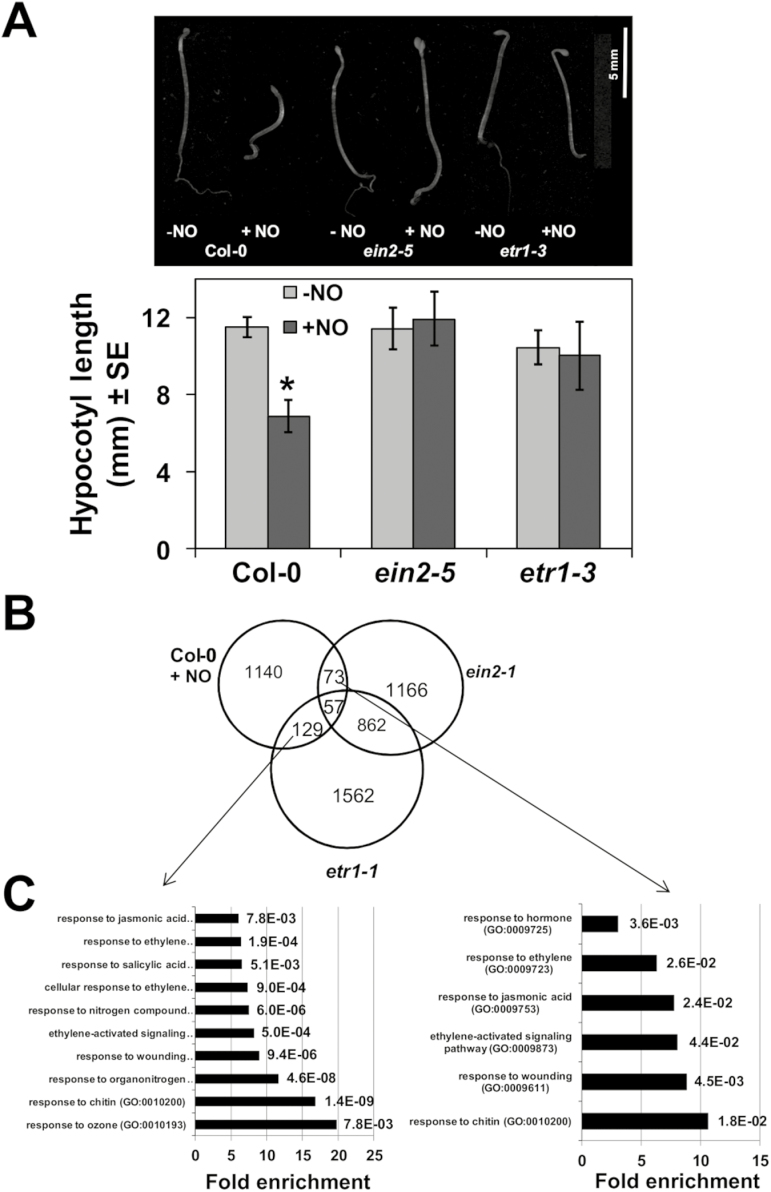
Ethylene perception and signaling is required for NO sensing. (A) Hypocotyl length of untreated (–NO) and NO-treated (+NO) wild-type and ethylene signaling-related mutant seedlings. Values are the mean ±SE (n=25) with * representing P-values <0.05 in Student’s t-test. (B) Venn diagrams representing the intersection between the NO-responsive transcriptome and those differentially regulated in etr1 and ein2 mutants. (C) Gene Ontology analysis of the genes found in the intersection between the NO-responsive and etr1-regulated (left panel) or ein2-regulated (right panel) transcriptomes. Fold enrichment (black bars) and the FDR-corrected P-values (at the right side of bars) for the functional categories are shown.